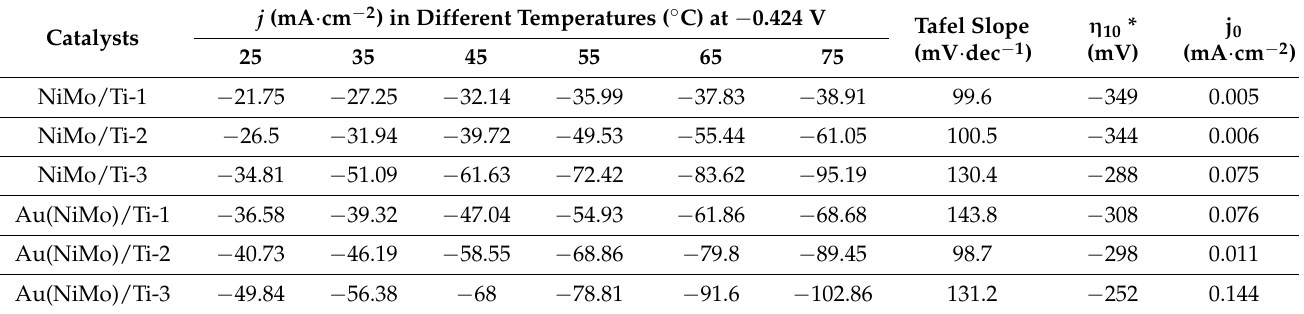
* Overpotential at 10 mA cm − 2 .